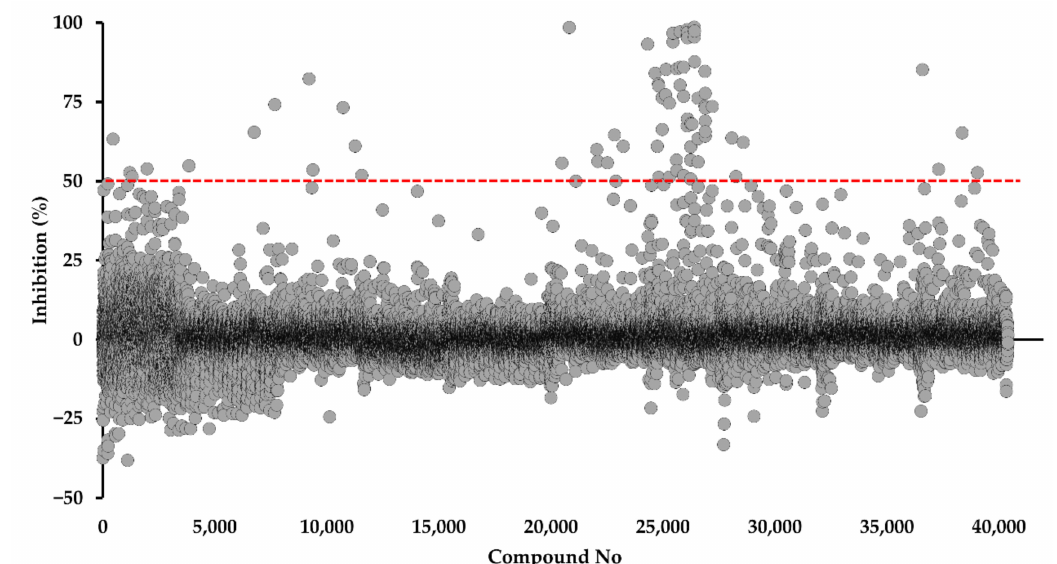
Figure 2. Screening of 40,400 compounds from Kyoto University chemical library against PfDHODH. The screening was performed at a final concentration of 4.5 µ M. The dashed line represents the 50% inhibition threshold for the selection of